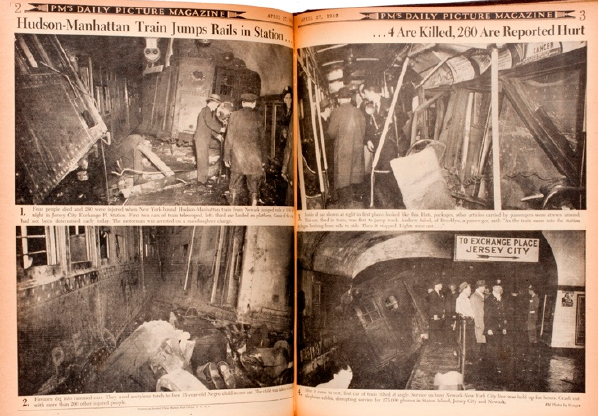
Figure 6. Weegee, “Hudson–Manhattan Train Jumps Rails in Station”, PM , 27 April 1942. Image courtesy of the International Center of Photography.